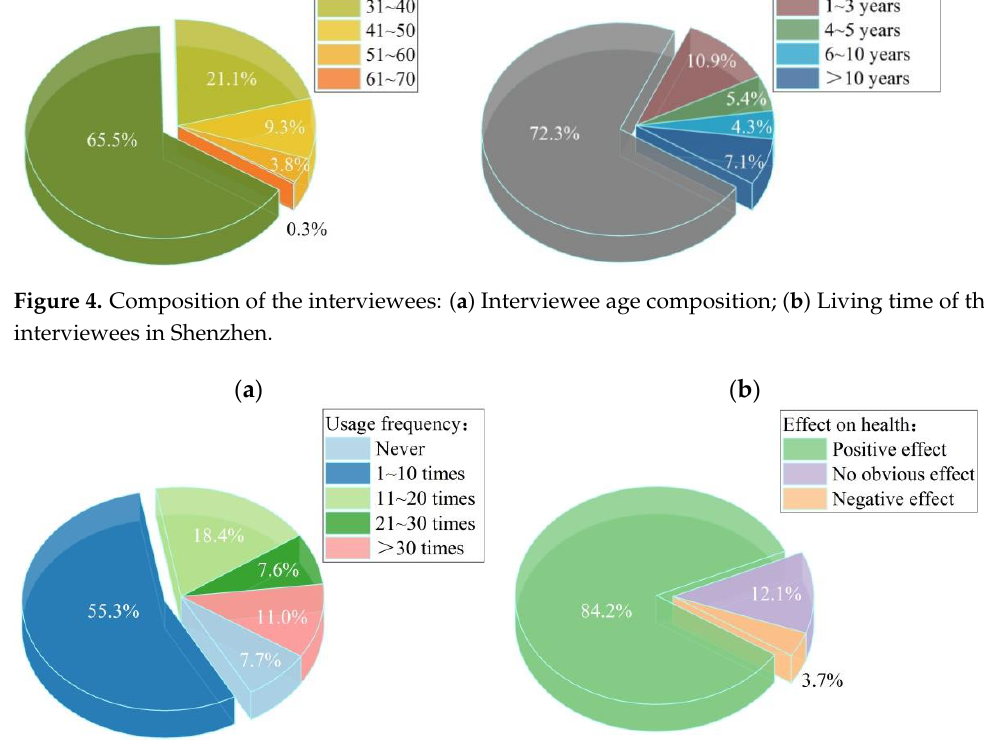
Table 3. Automatic linear models result (*, **, *** represent significance with 0.05, 0.01, and 0.001, respectively; +, − represent positive and negative correlation, respectively).